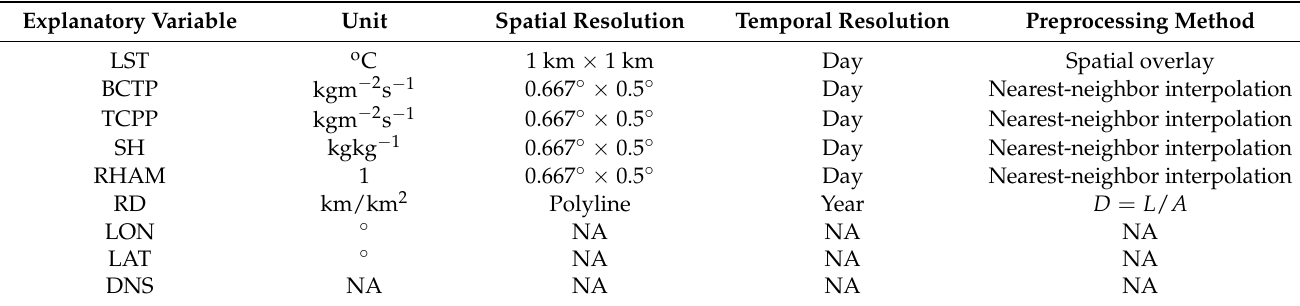
Table 2. List of explanatory